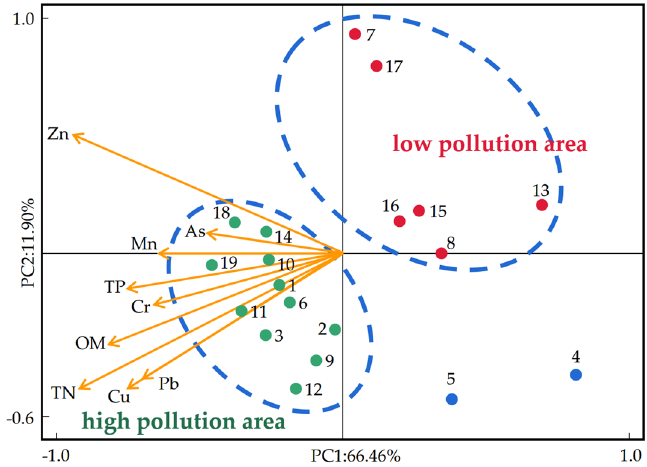
Figure 5. Principal component analysis of HMs with N and P pollutants in